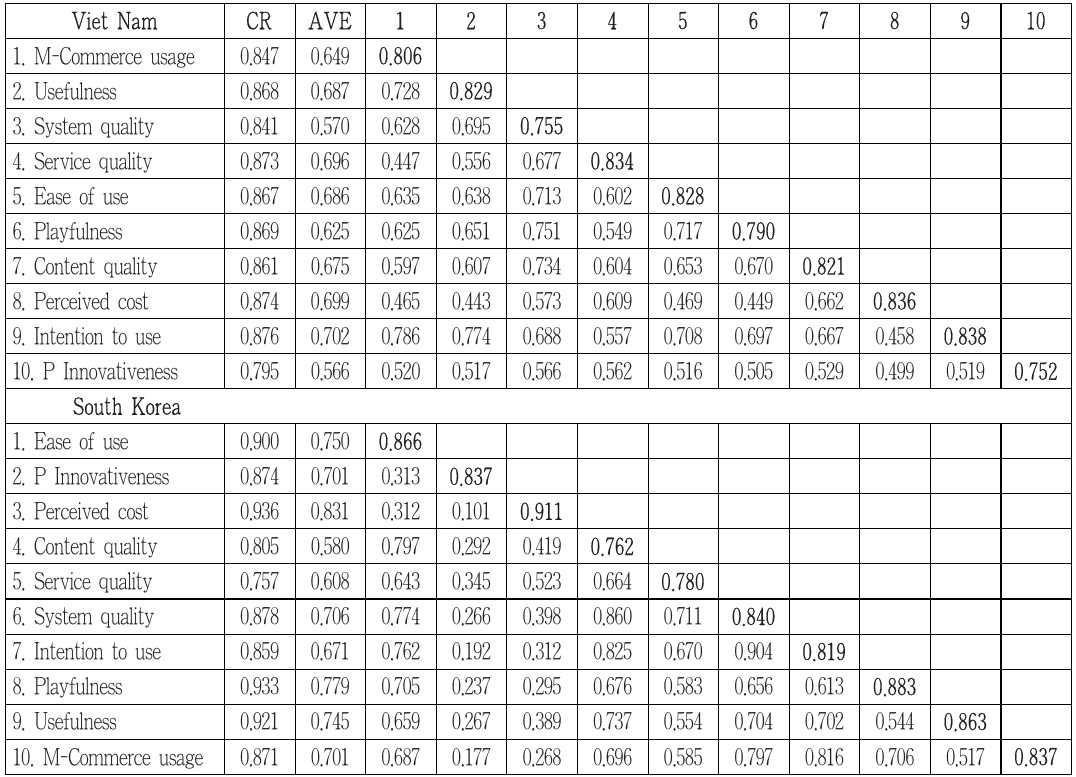
<Table 5> Composite reliability, AVE and correlation of constructs’